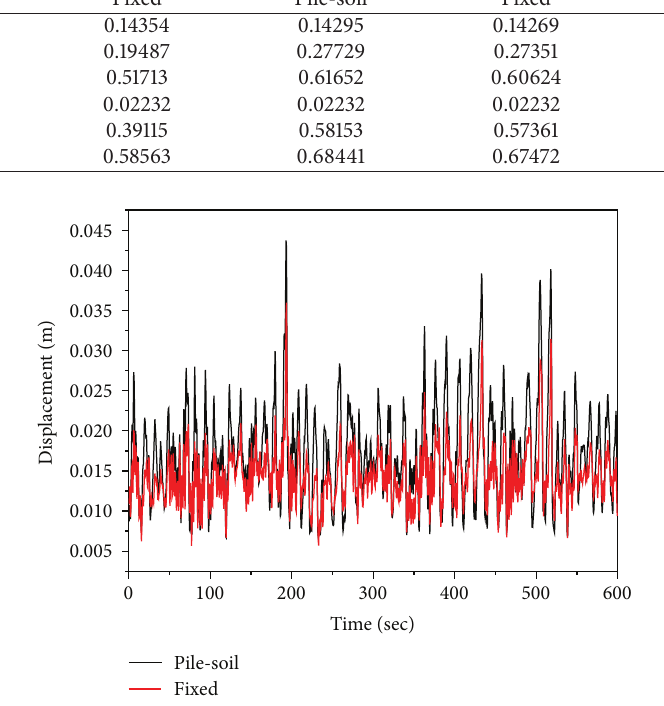
Figure 13: Maximum displacements with irregular wave at HSWL.